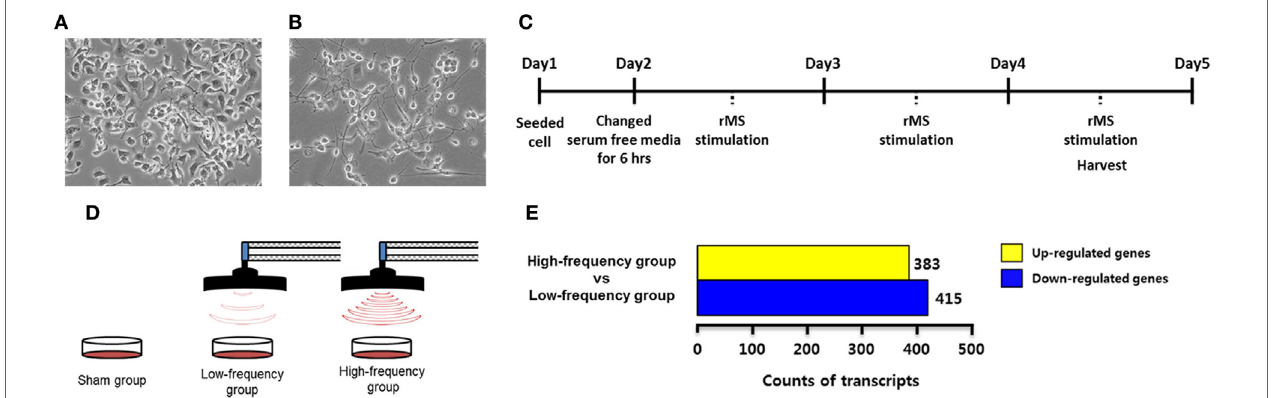
FigUre 1 | Experimental design and transcriptome analysis. (a) Undifferentiated Neuro-2a cells. (B) Neuro-2a cells were differentiated for 4 days with 2% fetal bovine serum and retinoic acid in Dulbecco’s Modified Eagle Medium. (c) A timeline of the experimental procedures. (D) A scheme of repetitive magnetic stimulation (rMS) treatment in Neuro-2a cells. The cultured cells were divided into the sham group, the low-frequency group, and the high-frequency groups and were each stimulated over 3 days. (e) Bar graphs show the number of differentially expressed genes with fold change ≥ |1.5| in the high-frequency group compared with the low-frequency group.